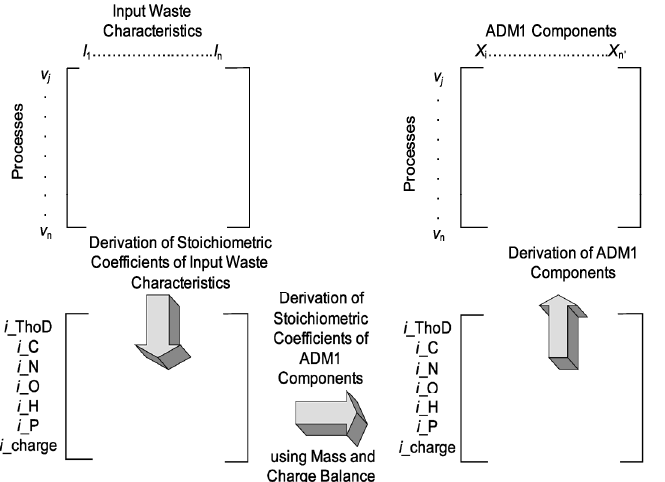
Figure 3. Illustration of major modeling steps of Namuli et al. (2011, under Creative Commons Attribution license) [53].